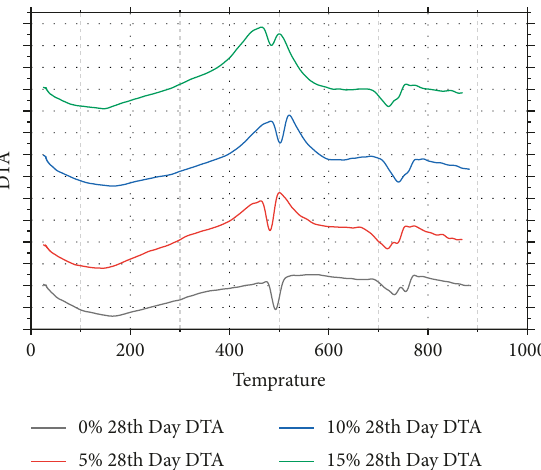
Figure 13: DTA for 28 th -day sample for different CHA.